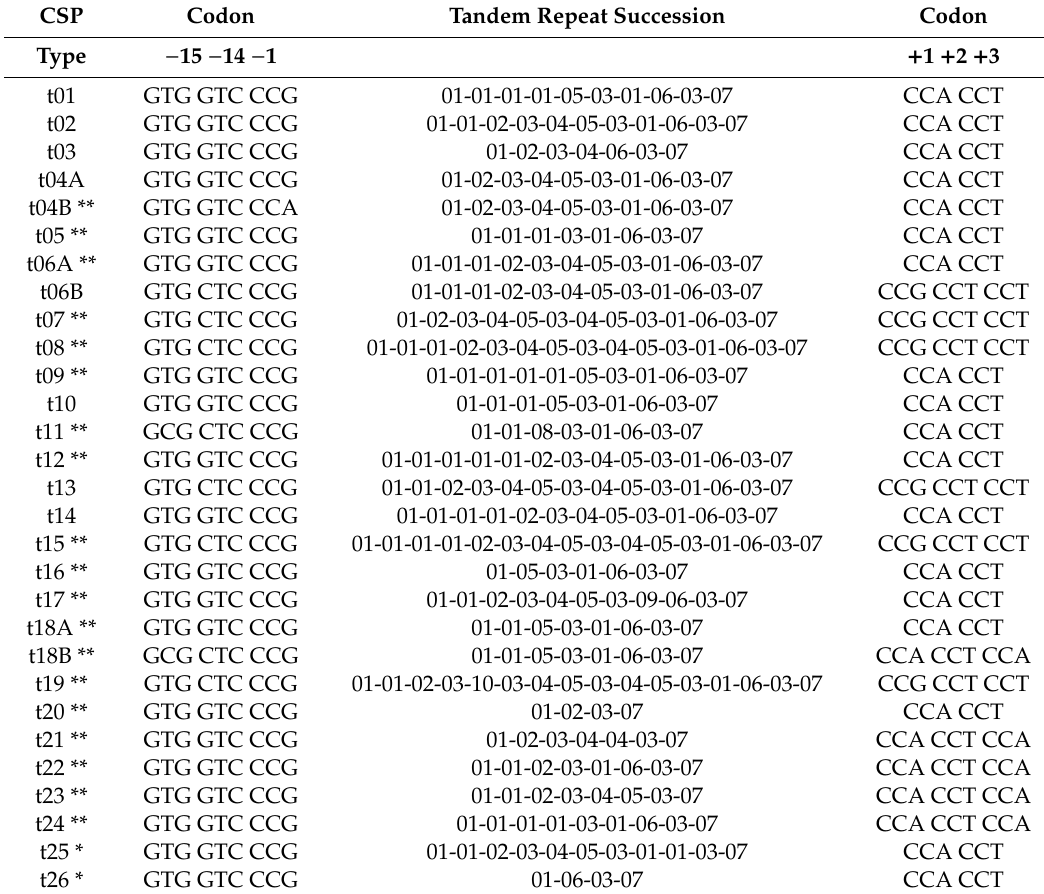
Table 4. CSP types identified to date among A. fumigatus